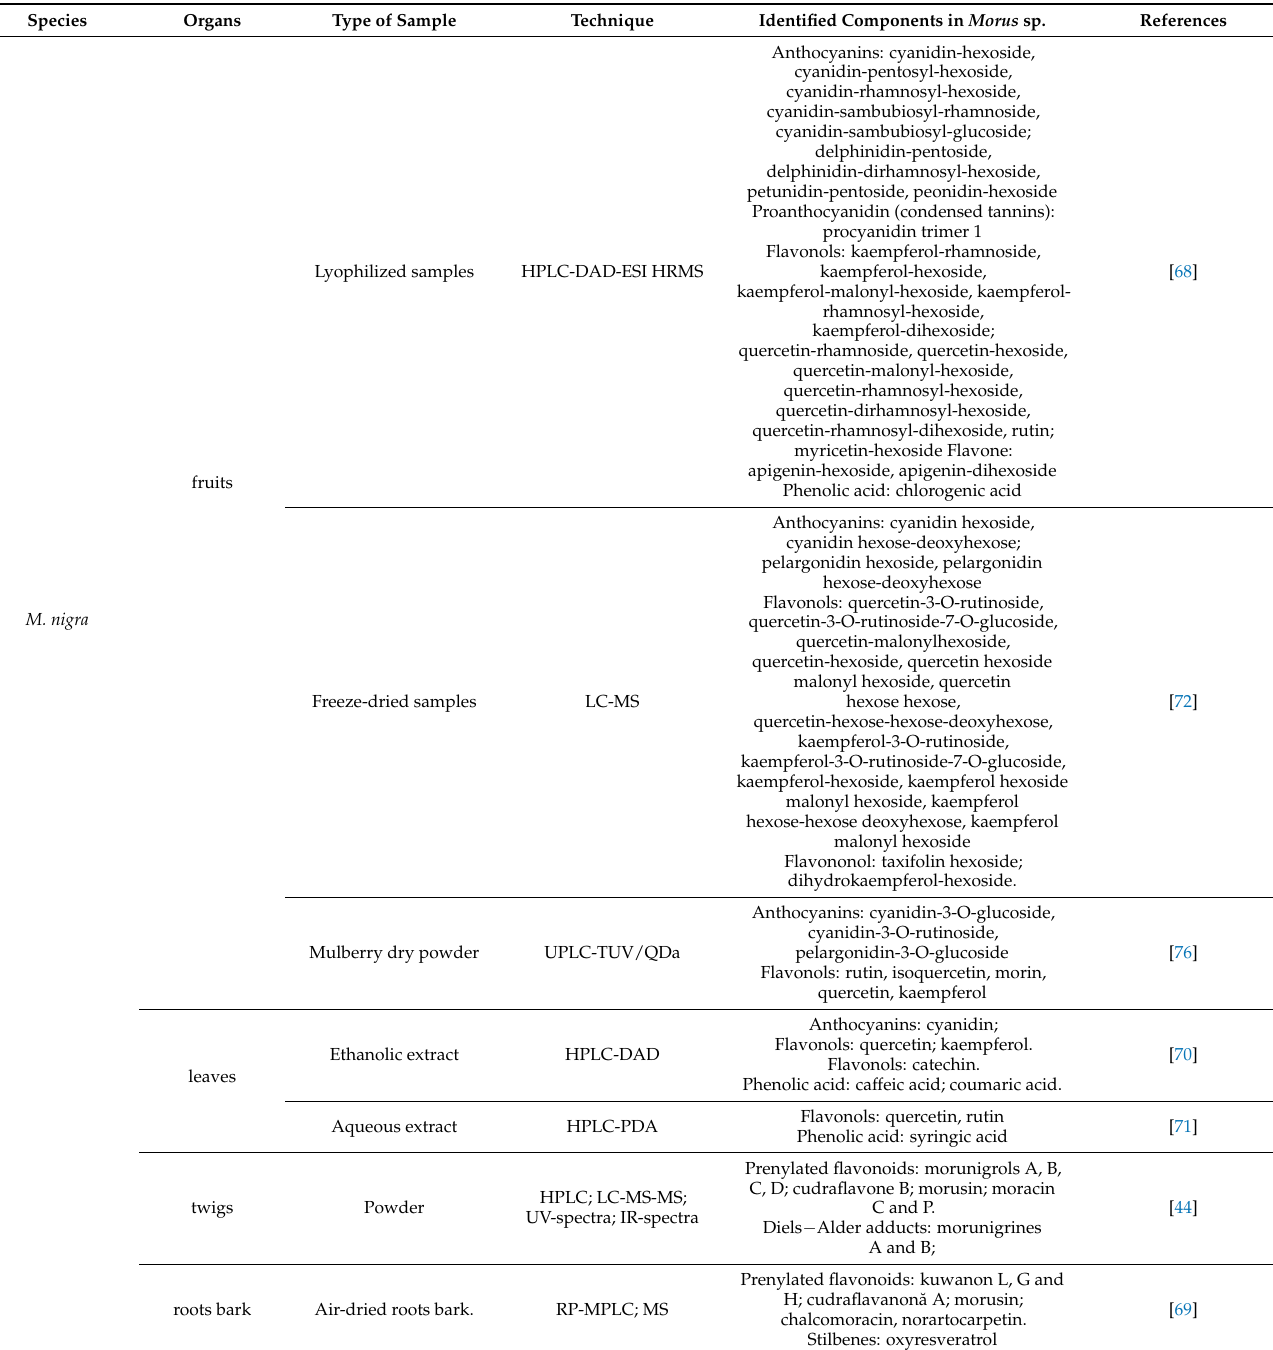
Table 2. Summary of phenolic components isolated from different parts of mulberry tree across- studies